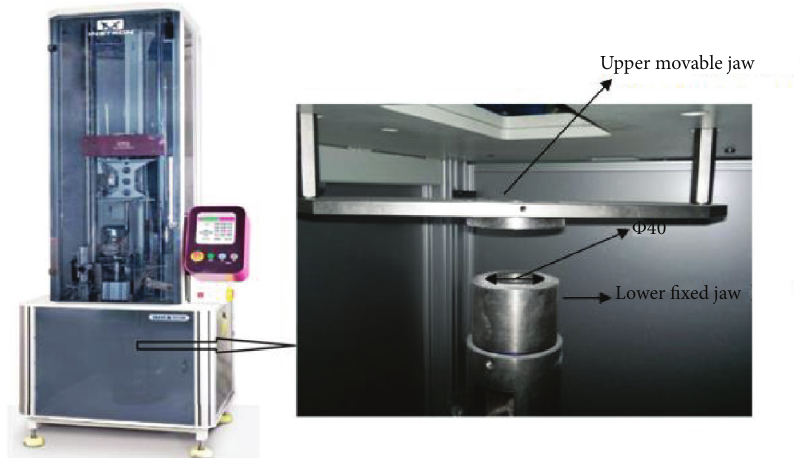
Figure 2: Drop Tower Impact Tester, Instron-CEAST 9350.